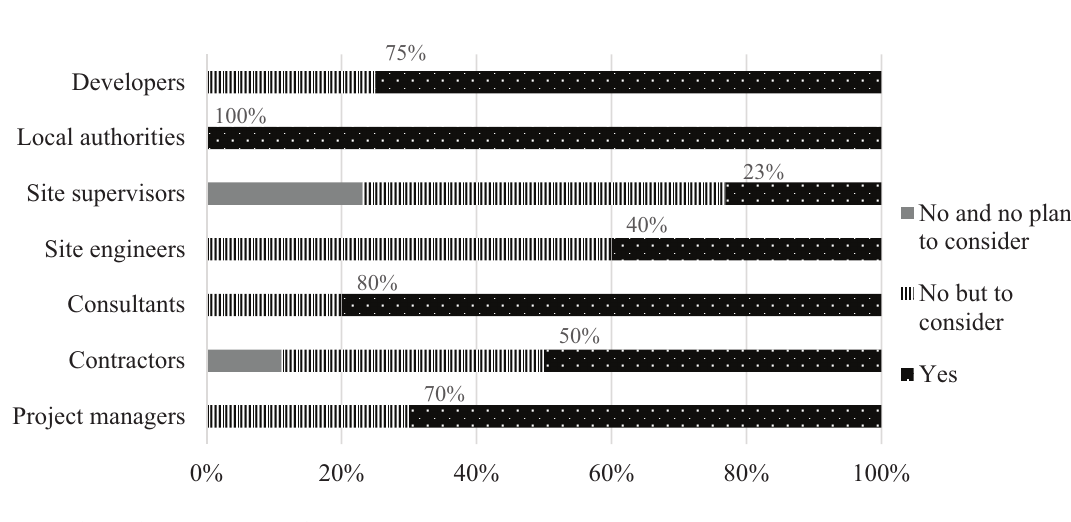
Figure 2. Consideration of the emissions management implementation